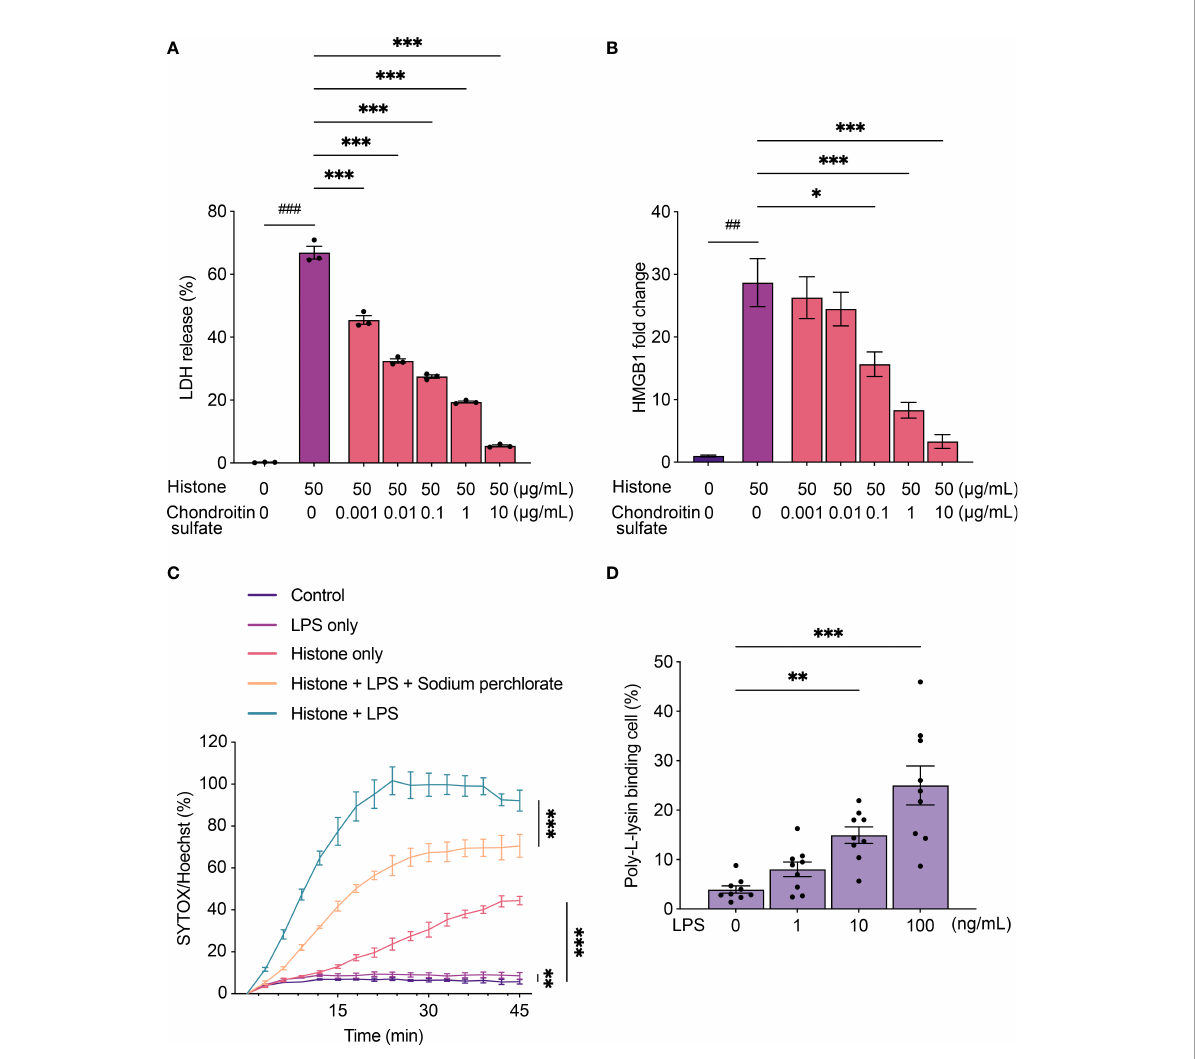
FIGURE 3 Chondroitin sulfate and lipopolysaccharides (LPS) regulate histone-induced cytotoxicity. (A) Lactate dehydrogenase (LDH) release assay using THP-1 cells to monitor histone-induced cytotoxicity for 24 h with chondroitin sulfate. (B) Levels of HMGB1 from THP-1 cells to monitor histone-induced cytotoxicity for 24 h with chondroitin sulfate. (C) Time-course plot of dead cells stained with SYTOX green evaluated by the Operetta cell imaging system after treatment with histone (100 m g/mL) and LPS (200 ng/mL) with sodium perchlorate (10 mM). (D) Poly-L-lysine binding to LPS-stimulated THP-1 cells. Data are expressed as the mean ± standard error of the mean. An unpaired t-test or a one-way ANOVA (A, B) or a two-way ANOVA (C, D) with Tukey – Kramer multiple comparison tests were conducted. * P < 0.05, ** P < 0.01, and *** P < 0.001. ## P < 0.01, and ### P < 0.001. Different statistical tests were presented with different symbols.. The experiments were performed with technical replicates of three wells per